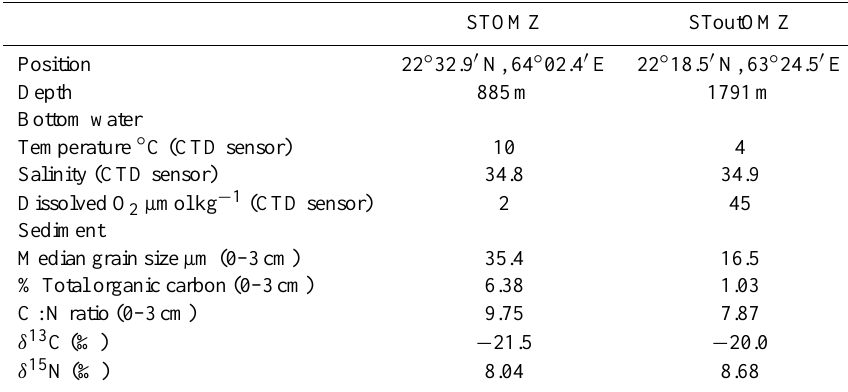
Table 1. Station locations, environmental parameters, water and sediment characteristics of the two sampling stations, STOMZ and SToutOMZ (after Pozzato et al.,